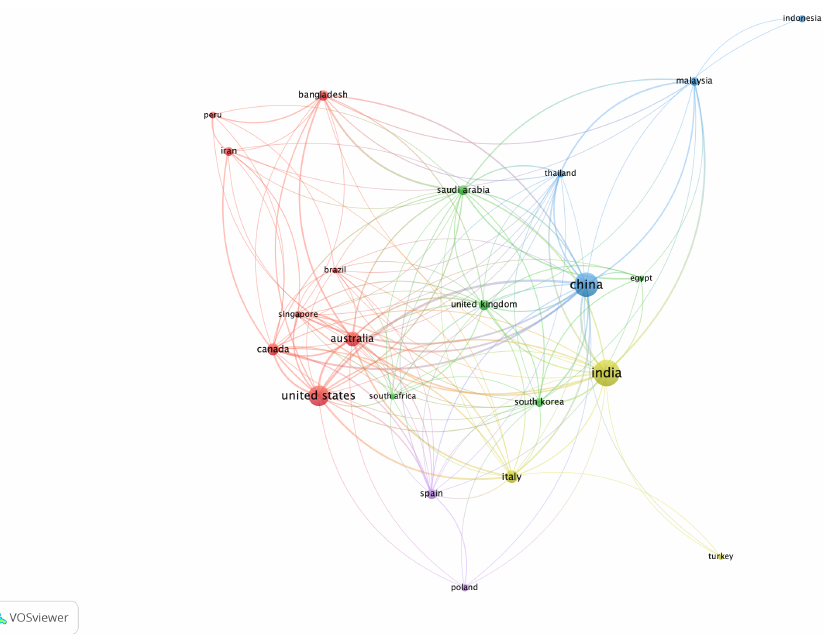
Figure 10. Country collaboration network visualization, including countries with a minimum of 10 documents in the